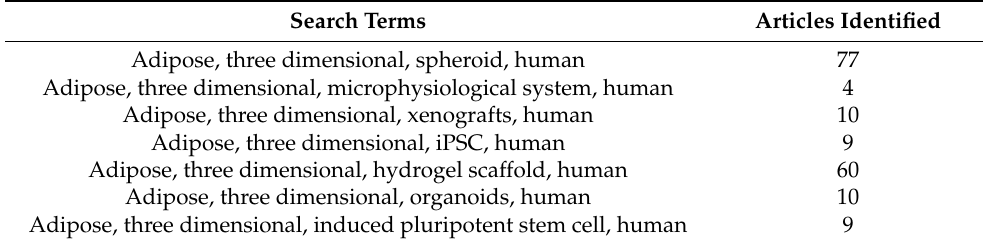
Table 1. Number of articles identified in PubMed using seven subsets of search terms.